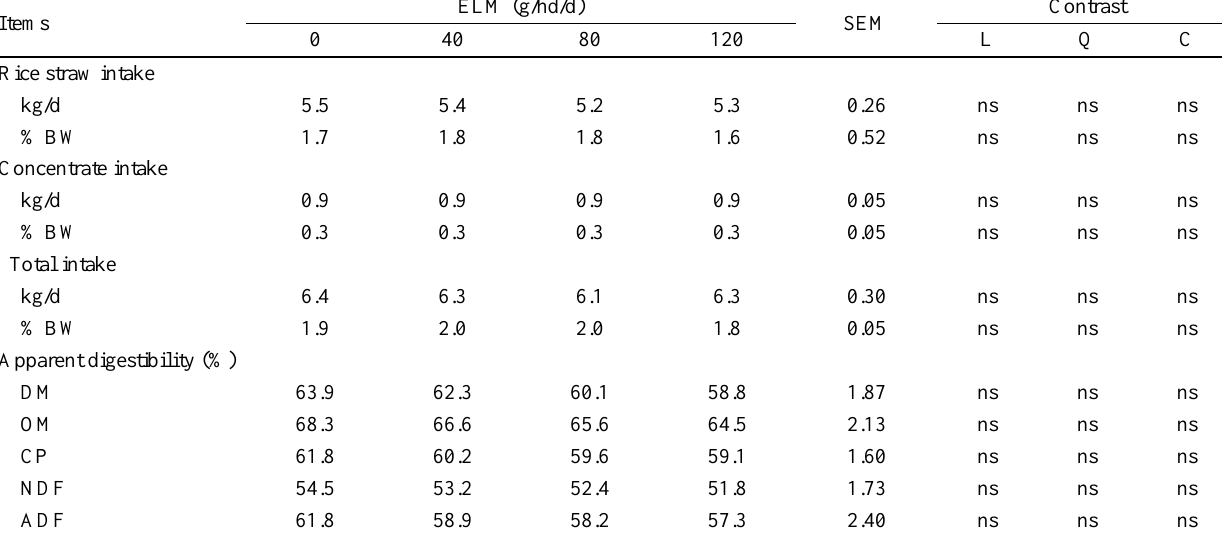
Table 2. Effects of Eucalyptus leaf meal supplementation on voluntary feed intake and nutrient digestibility